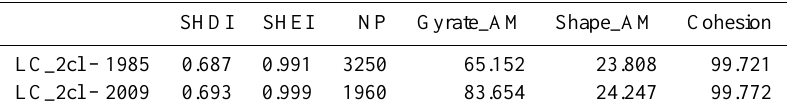
Figure 6. Histograms of the used metrics at class level for natural covers for the complex ecomosaics (1985–2009). For further details on landscape indicators see Table 1. Table 5. Results of metrics applied at landscape level for the forest/non-forest ecomosaic for the years 1985–2009. The suffix AM means “area-weighted